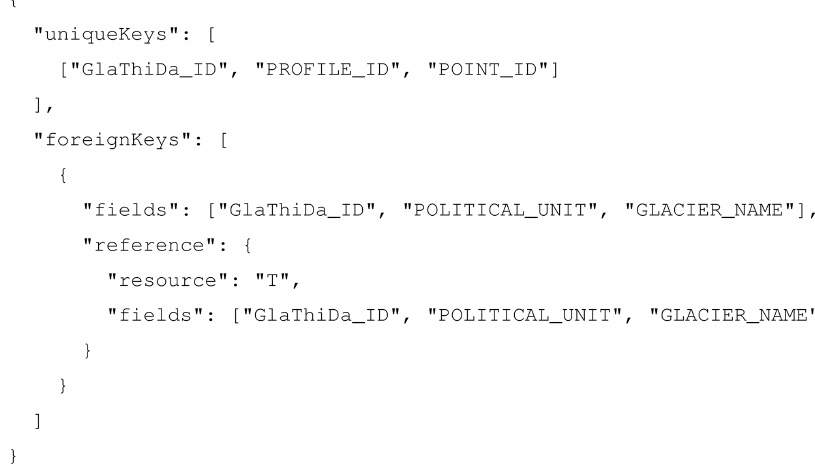
Figure 5. Sample JSON from datapackage.json specifying the unique keys and foreign keys for table TTT .